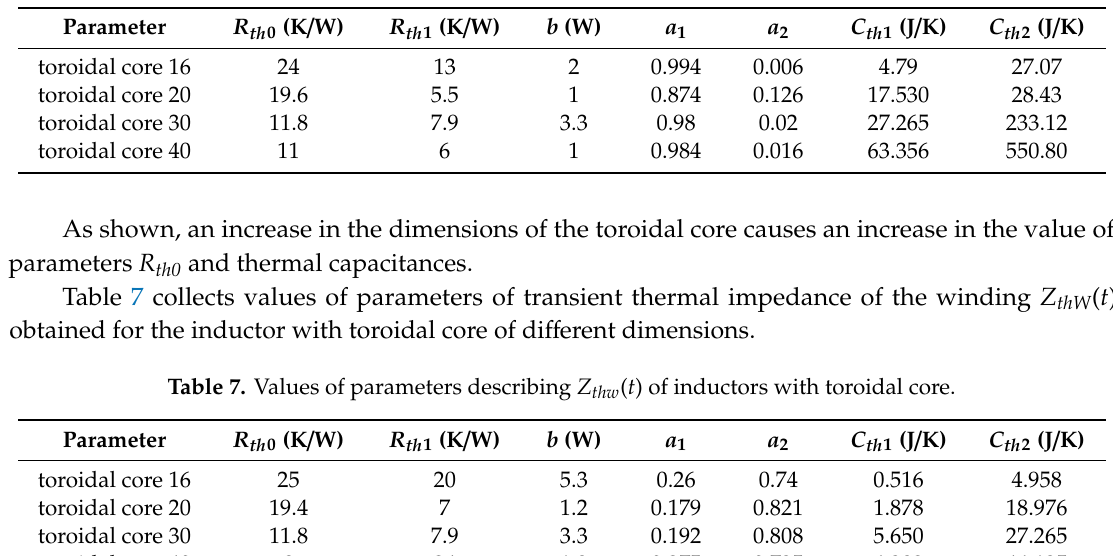
Table 6. Values of parameters describing Z thC ( t ) of inductors with toroidal cores of di ff erent dimensions.